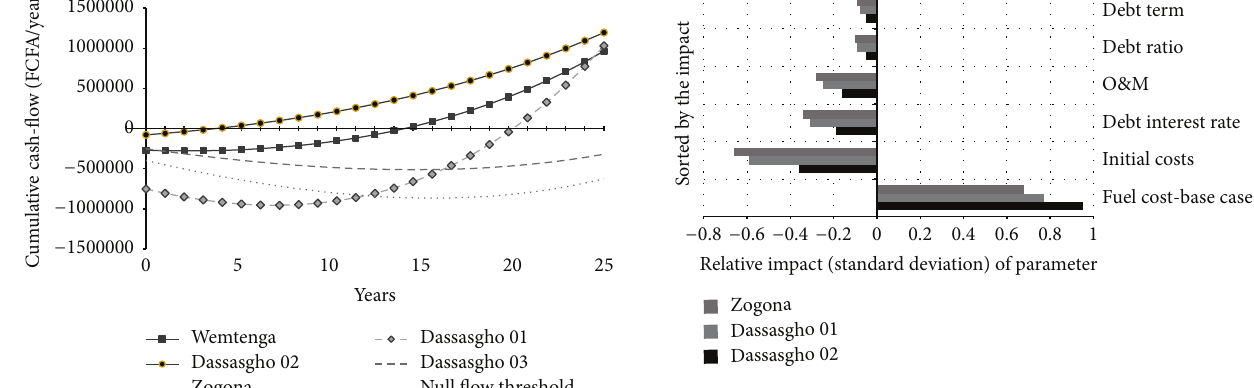
Figure 6: NPV risk analysis at a range of 10% evaluated by RETScreen. All costs in FCFA XOF and the debt term in a year for a real discount rate of 5%. Negative values indicate outcome, while positive values indicate income